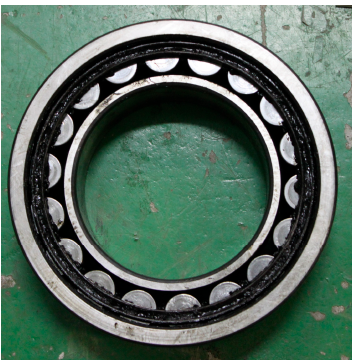
Figure 5. The healthy bearing.